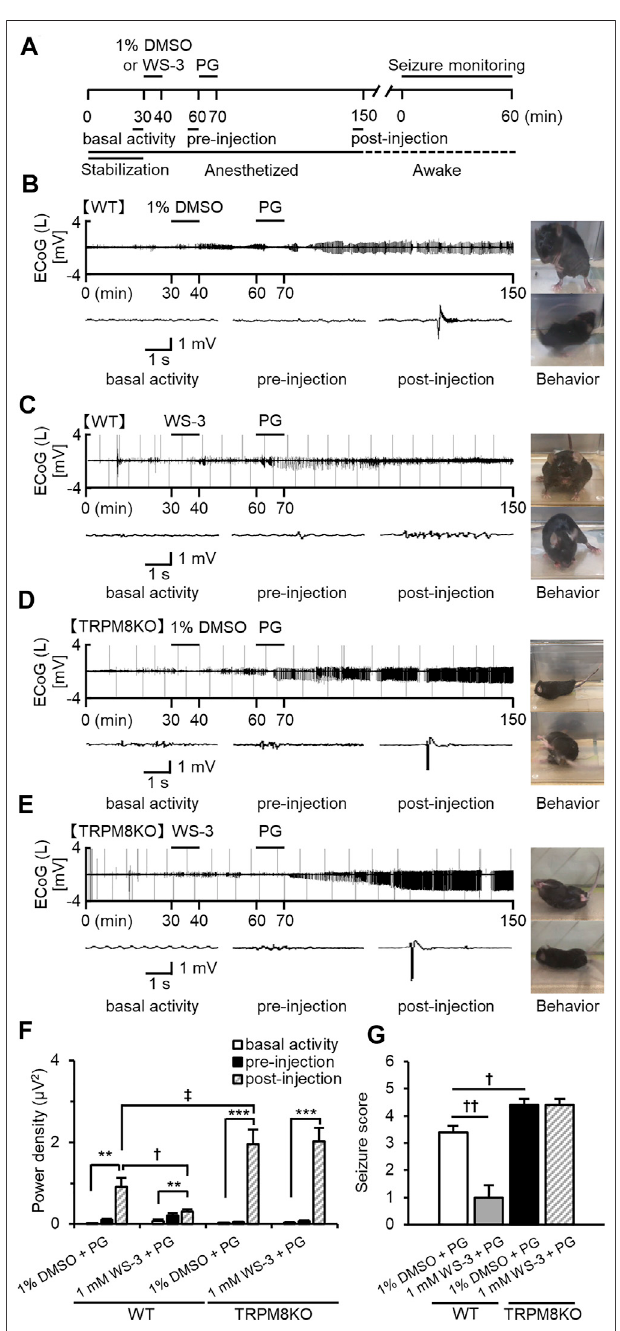
FIGURE3 |betabandinthecontralateralsideduringbasalactivity(white)and the pre-injection (black) period. (G) Mean seizure scores that were at the maximum during the 60-min period for vehicle (white) or WS-3 (grey) ad- ministration in WT mice and for vehicle (black) or WS-3 (grey-oblique line) administration in TRPM8KO (black) mice. The results are shown as mean ± SEM;** p < 0.01, *** p < 0.001,followed byTukey ’ stest; † p < 0.05, †† p < 0.01, Student ’ s t -test; ‡ p < 0.05, Welch ’ s t